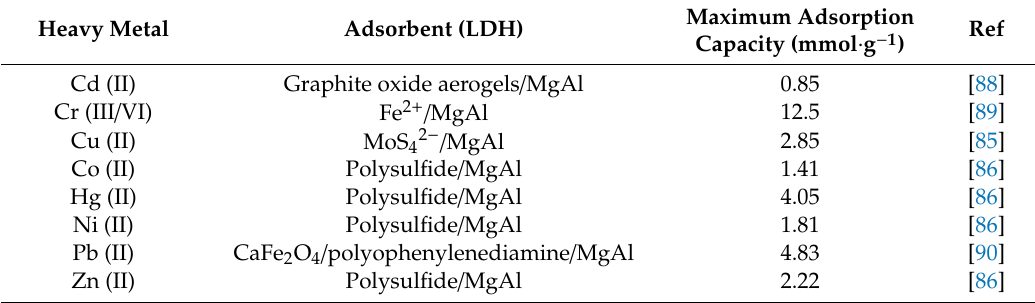
Table 3. Maximum adsorptive performance (comparatively) of di ff erent LDHs towards a variety of metal cations